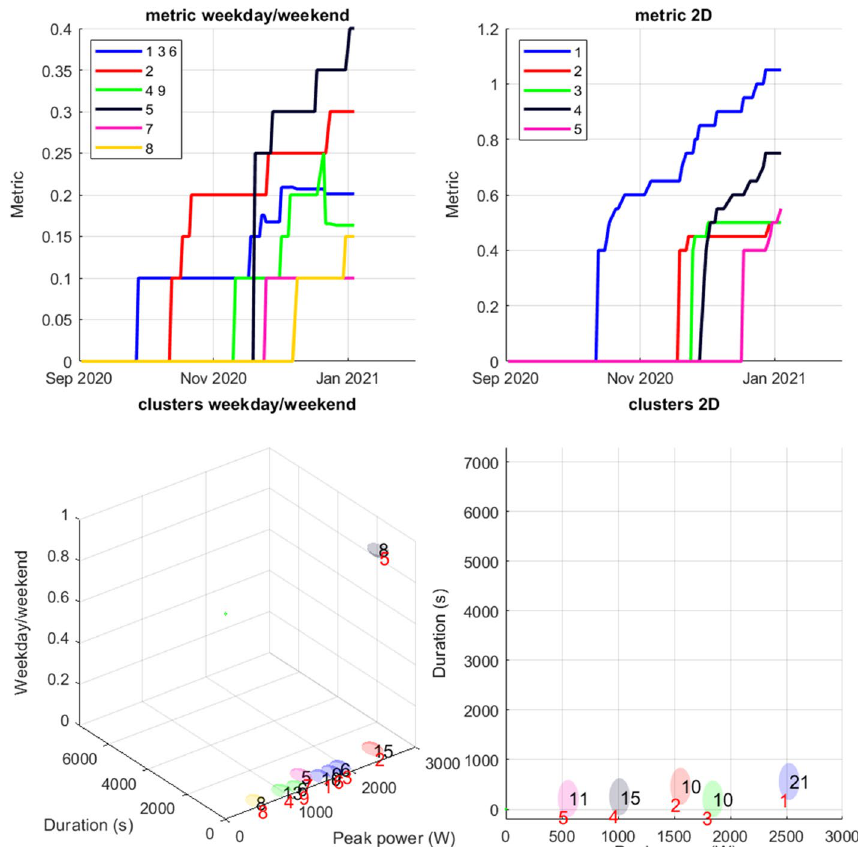
Fig. 3 Evolution of the quality metric during the online clustering process with the features combinations { peak power , duration , weekday/weekend } on the left and { peak power , duration } on the